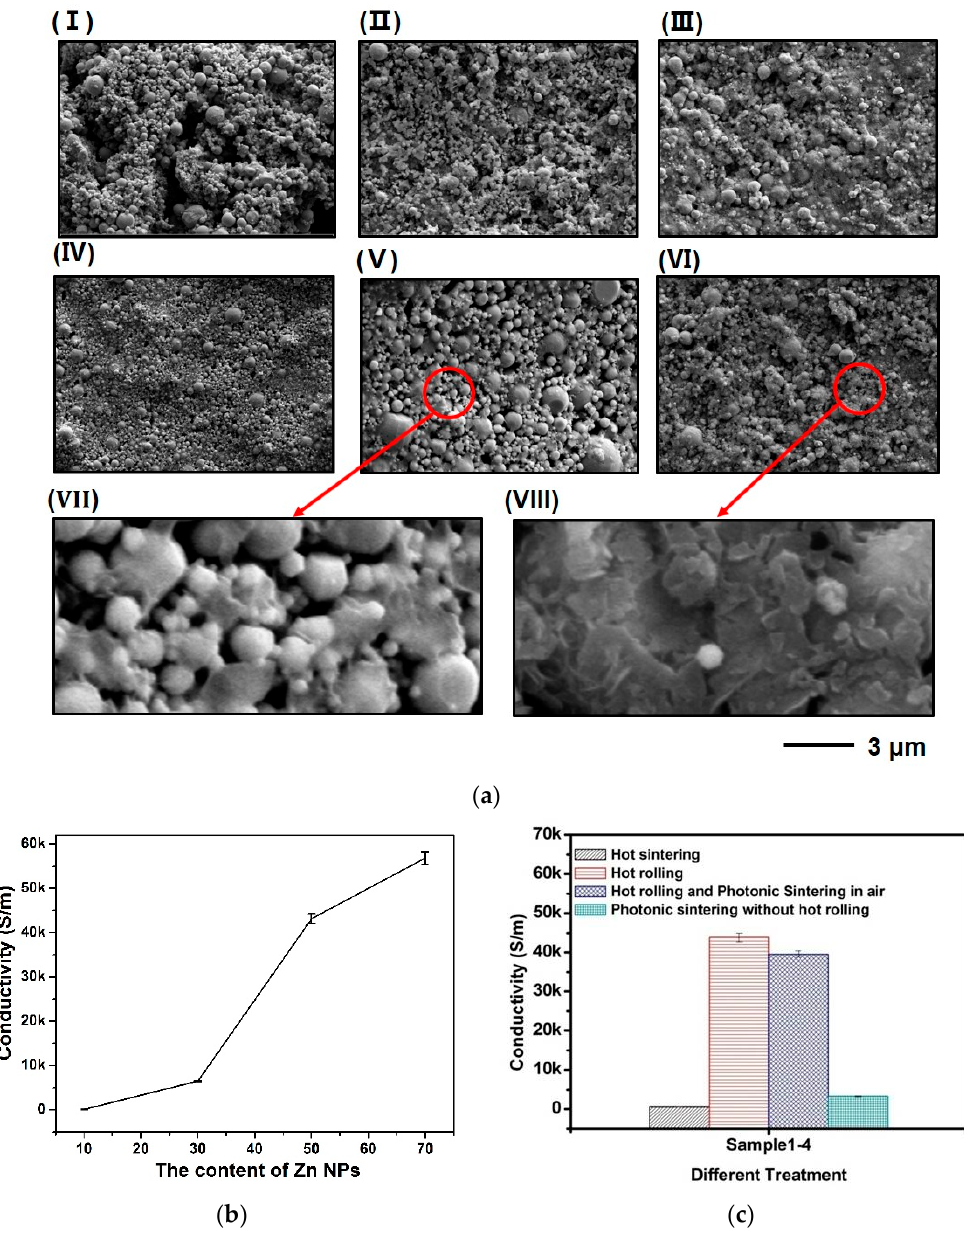
Figure 2. ( a ) The surface morphology of printed patterns using different content of Zn NPs at ( I ) 10 wt%, ( II ) 30 wt%, ( III ) 50 wt%, and ( IV ) 70 wt%. ( V ) and ( VI ) represent that patterns treated without and with hot rolling, respectively. (both of them without photonic sintering). ( VIII ) and ( VII ) represent amplified images of ( VI ) and ( V ), respectively; ( b ) The conductivity of patterns using different content of Zn NPs; ( c ) The conductivity of printed pattern under different treatments.